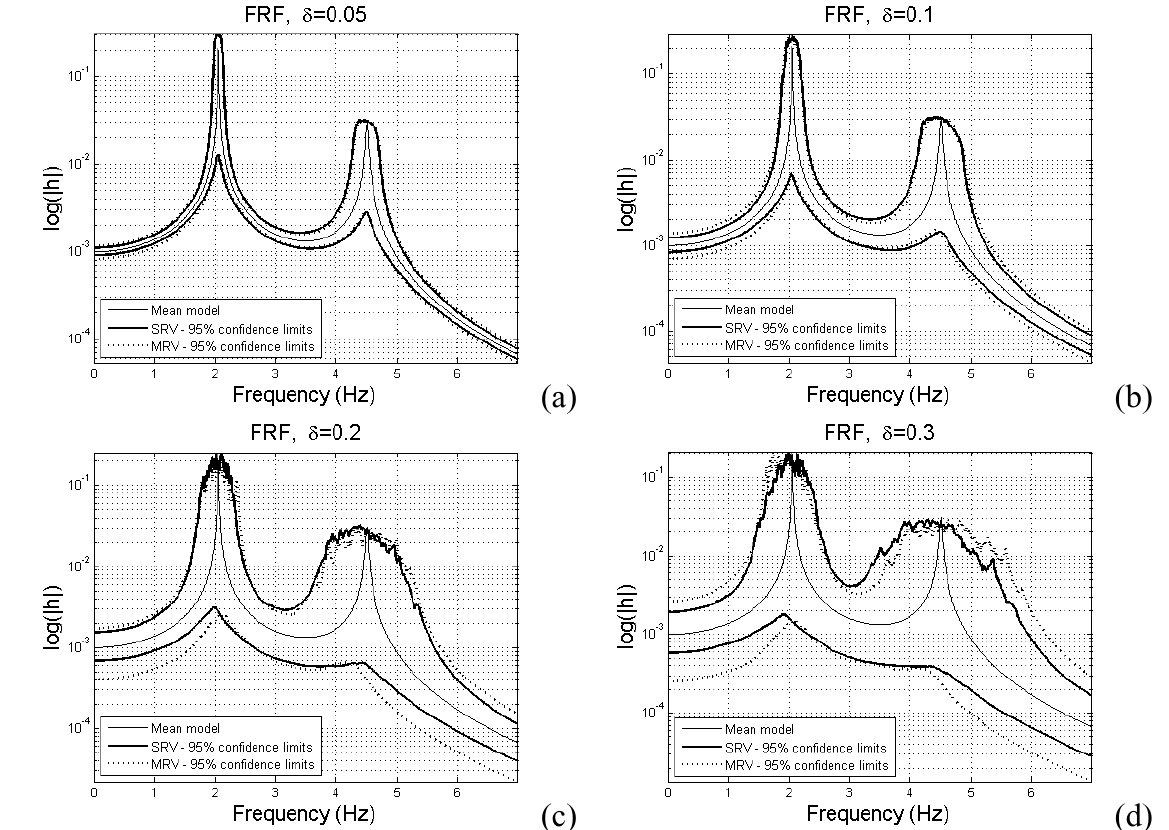
Fig. 4. Results for the FRF of the mean model with 95% confidence limits for both approaches (SRV MRV). (a) δ K 1 = δ K 2 = δ